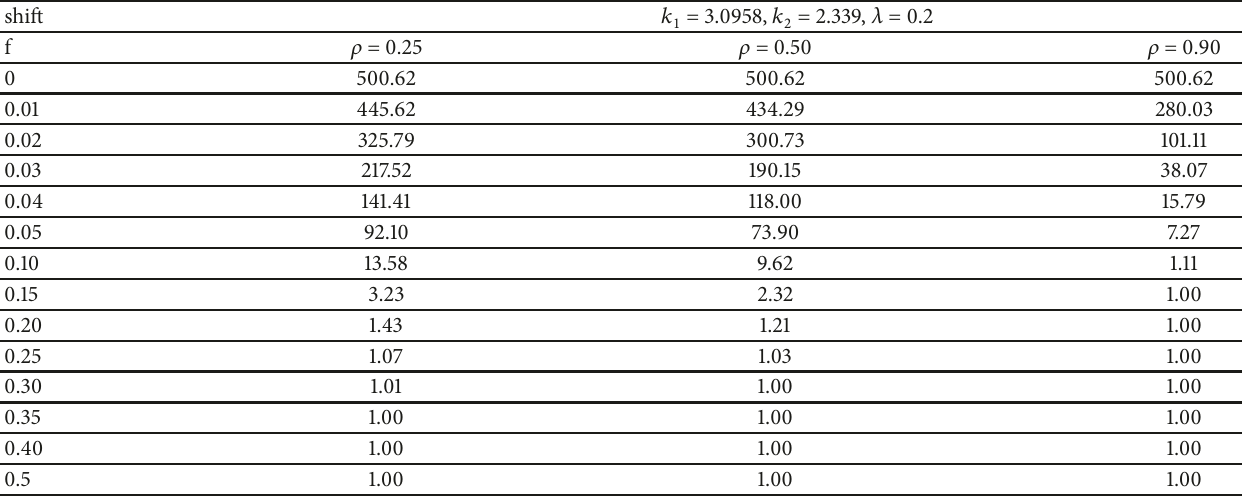
Table 8: ARLs for proposed repetitive EWMA-RSS control chart using Khan et al. [8] exponential ratio-type estimator, when 𝑟 𝑜 is 500.